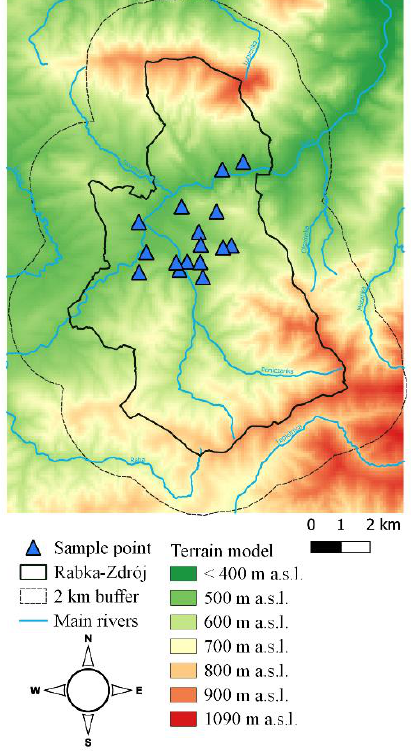
Figure 5. Location of groundwater samples in the town of Rabka-Zdrój.